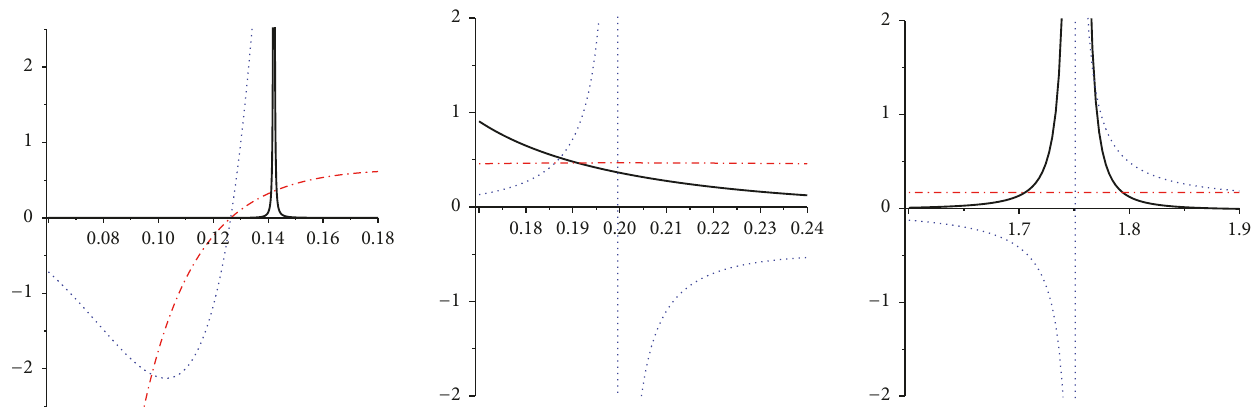
Figure 1: Weinhold metric. R (continuous line), 𝐶 𝑄 (dotted line), and 𝑇 (dot dashed) versus 𝑟 + for Λ = −1 , 𝑛 = 4 , 𝑞 = 0.1 , 𝑏 = 1 , 𝜔 = 10 , and 𝛽 = 1.5 . “Note: all three panels are plotted with the same parameters, but different regions and scales.”